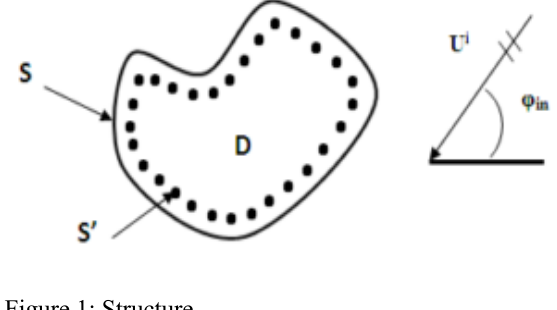
Figure 1: Structure In the standard MAS, the incident field on the cylinder produces a scattered field. This field is radiated by N auxiliary sources that are regularly distributed on a fictitious surface inside the PEC